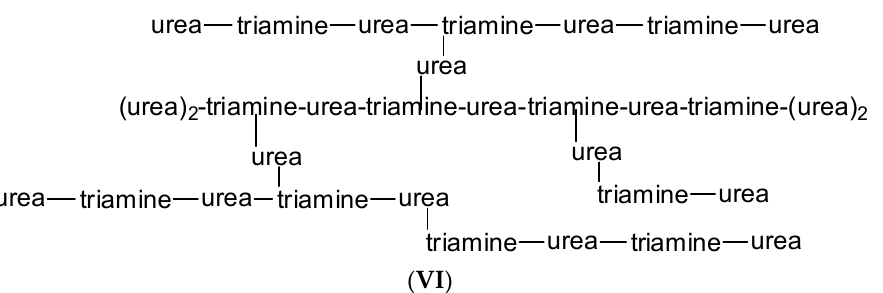
Figure 7. The only cyclic structure detected of the reaction of triamine with urea.